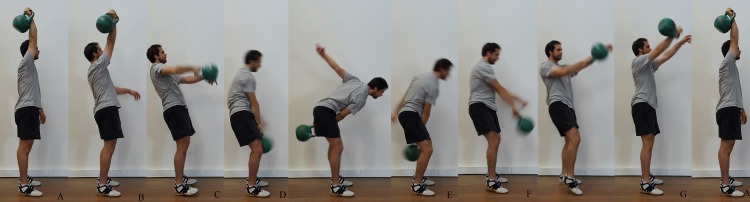
Illustrates the phases of the kettlebell snatch.(A) fixation, (B) drop, (C) re-gripping, (D) back swing, (E) forward swing, (F) acceleration pull, (G) hand insertion, (A) fixation.